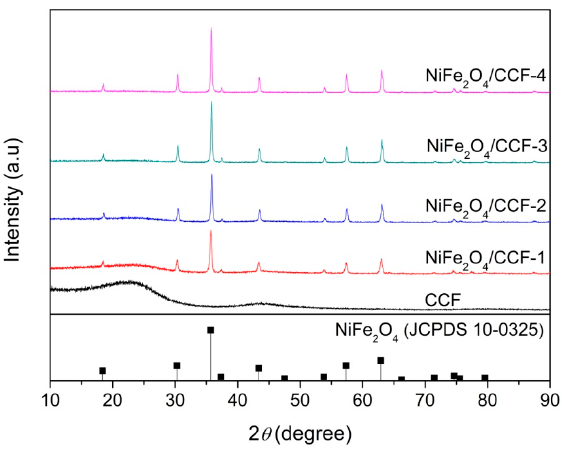
Figure 1. XRD patterns of CCF, NiFe 2 O 4 /CCF-1, NiFe 2 O 4 /CCF-2, NiFe 2 O 4 /CCF-3, and NiFe 2 O 4